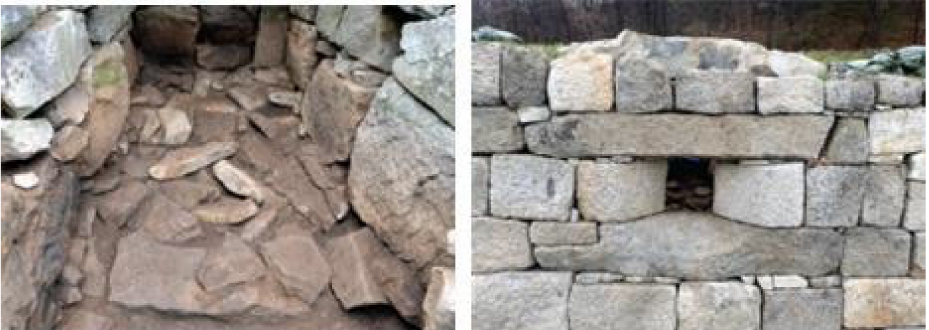
Figure 7. Geonpyeong Dondae: emplacement ( left ) and its embrasure ( right ). Reprinted with permission from Ref. [34]. 2017, Incheon Metropolitan City